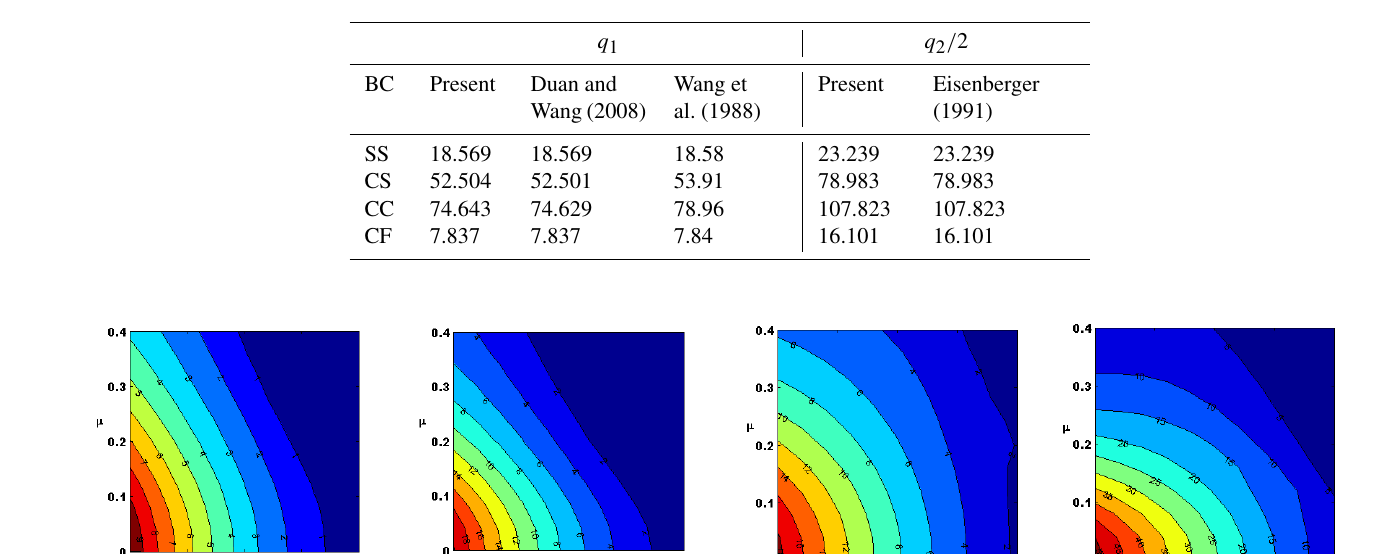
Table 2. Comparison of buckling loads under distributed loads with existing results for four boundary conditions with µ = 0 (local beam).